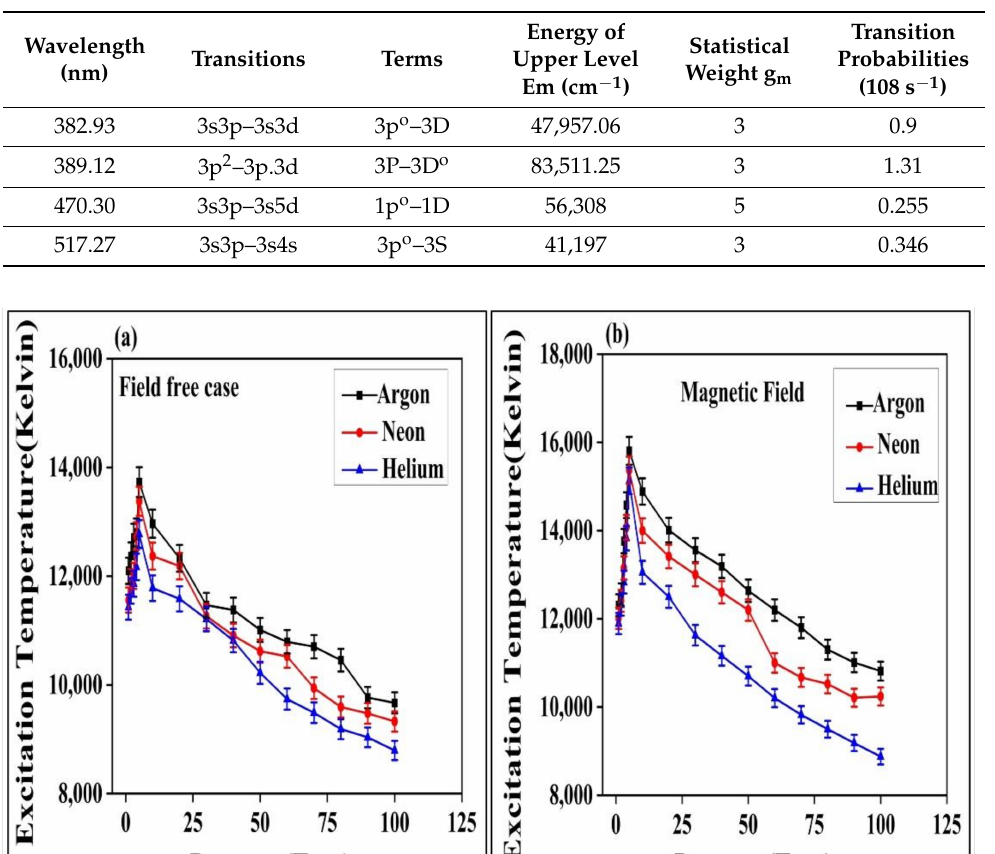
Table 1. Spectroscopic parameters of Mg I lines obtained from the NIST Database and the existing literature [28].